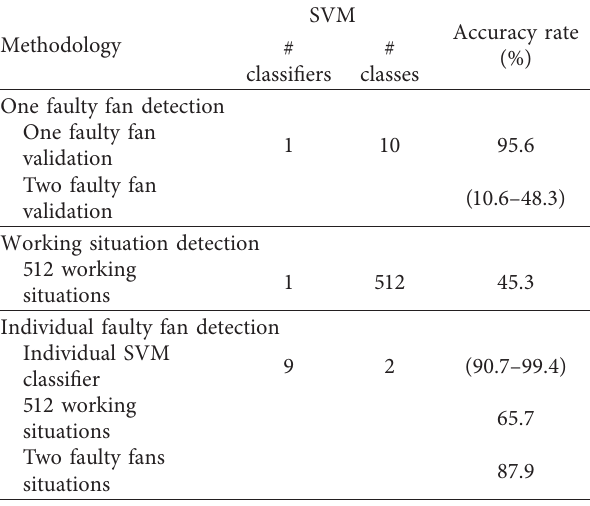
Table 4: SVM accuracy rates of the detection